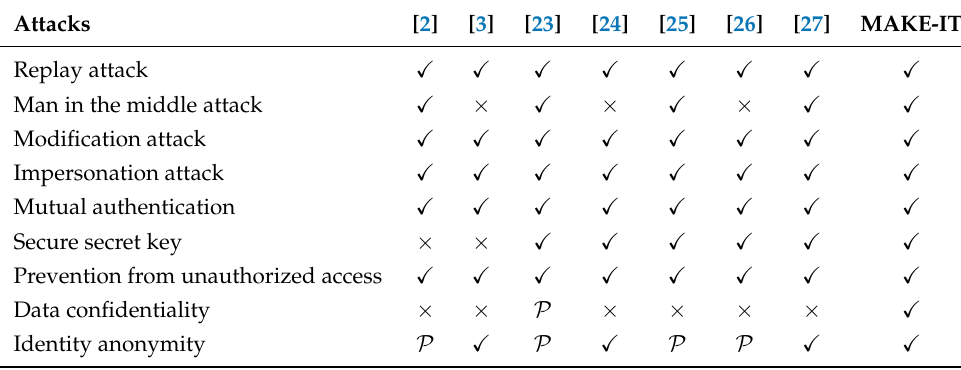
Table 7. Analysis and Comparison of Protocols based on protection against attacks and security goals.